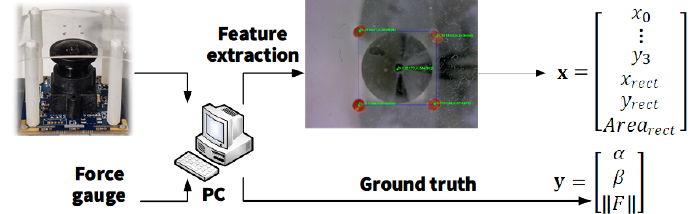
Figure 9. Workflow to generate one data set